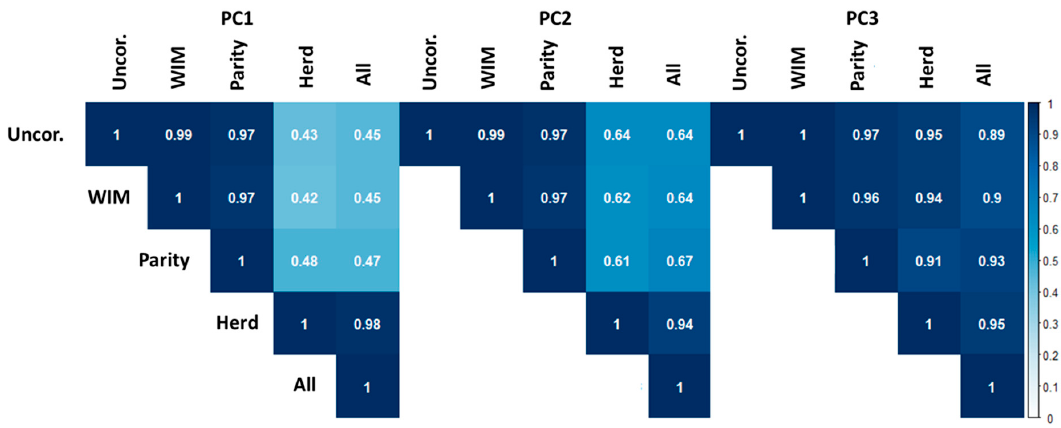
Figure 3. Pearson’s correlations between scores derived from PCA of uncorrected 1 H NMR spectra of bovine serum, and the same spectra corrected using linear regression for week of lactation (WIM), parity, herd of origin, and WIM, parity, and herd simultaneously (All). Color map shows strength of Pearson’s correlation.